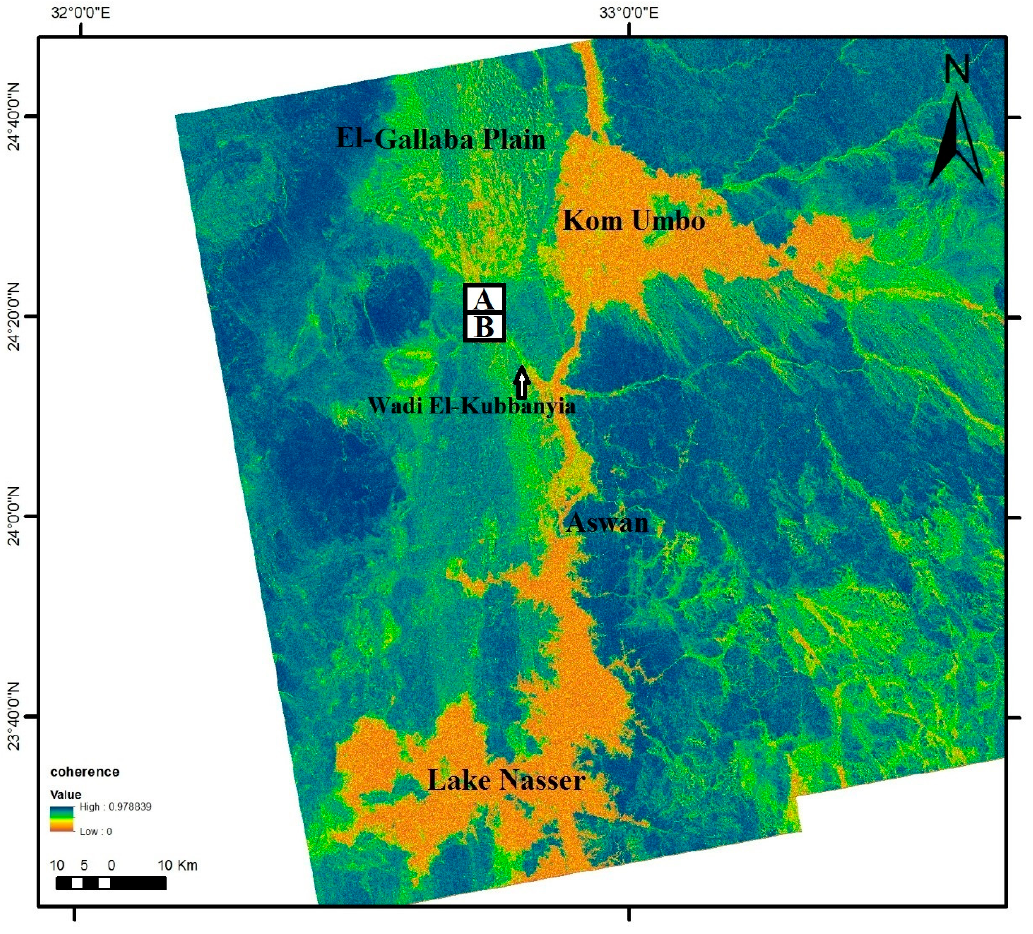
Figure 10. InSAR coherence images of the El-Gallaba Plain, southwest of Wadi El-Matulla, show low coherence values close to zero (brown and yellow colors for highly changed areas) and high coherence values close to 1 (blue color for nonchanged areas). The A and B boxes represent the zoomed-in areas of Figure 11.